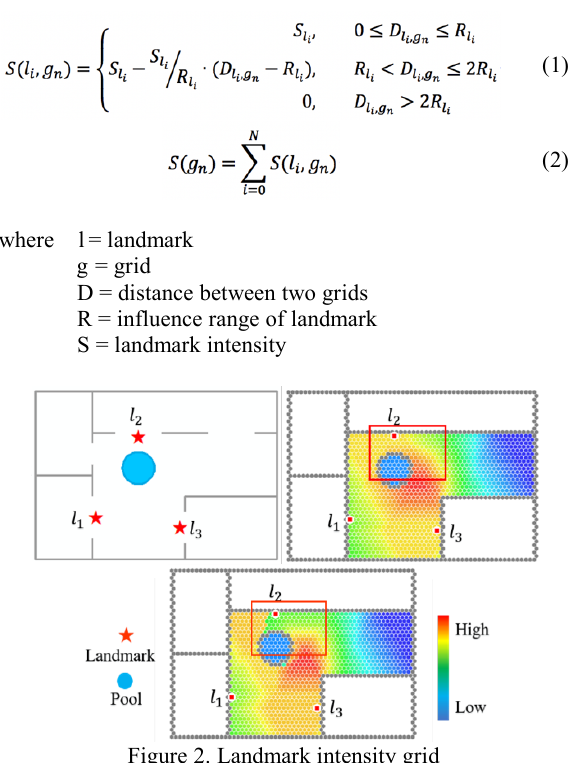
Figure 2. Landmark intensity grid